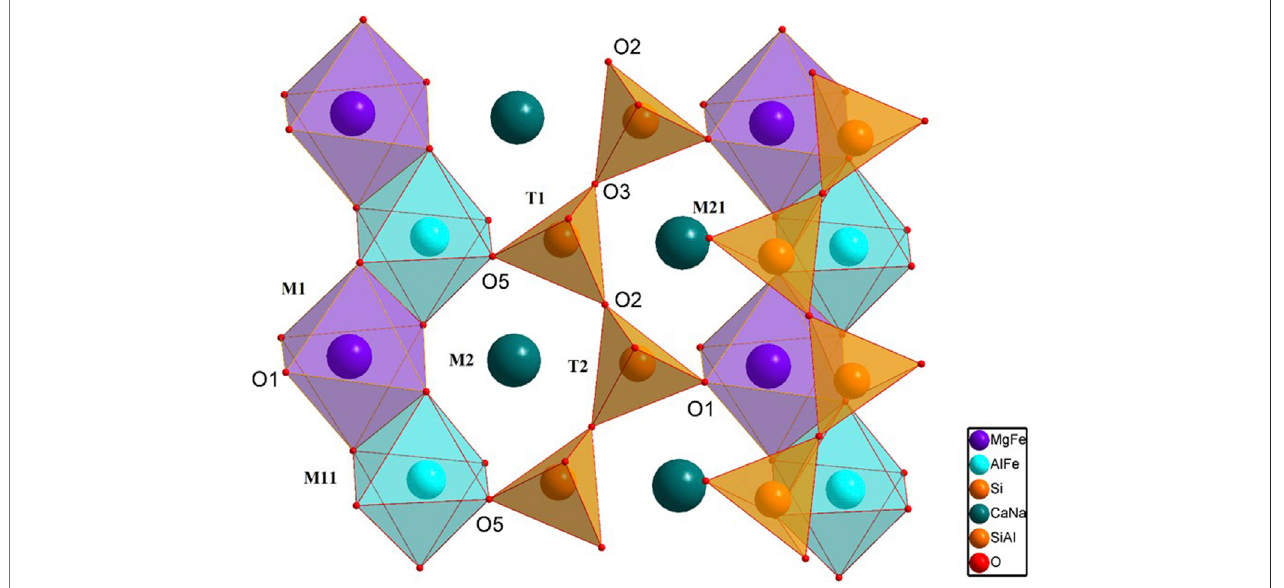
FIGURE 8 | Projection of the structure of omphacite viewed along the c -axis.